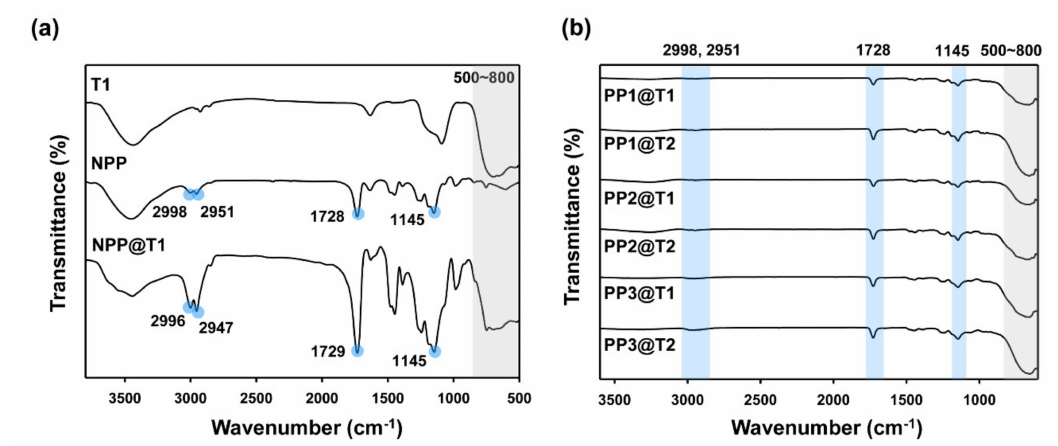
Figure 2. ( a ) FT-IR spectra of pure TiO 2 (T1), pristine PMMA (NPP), and organic-inorganic hybrid particles (NPP@T1). ( b ) FT-IR spectra of other porous hybrid